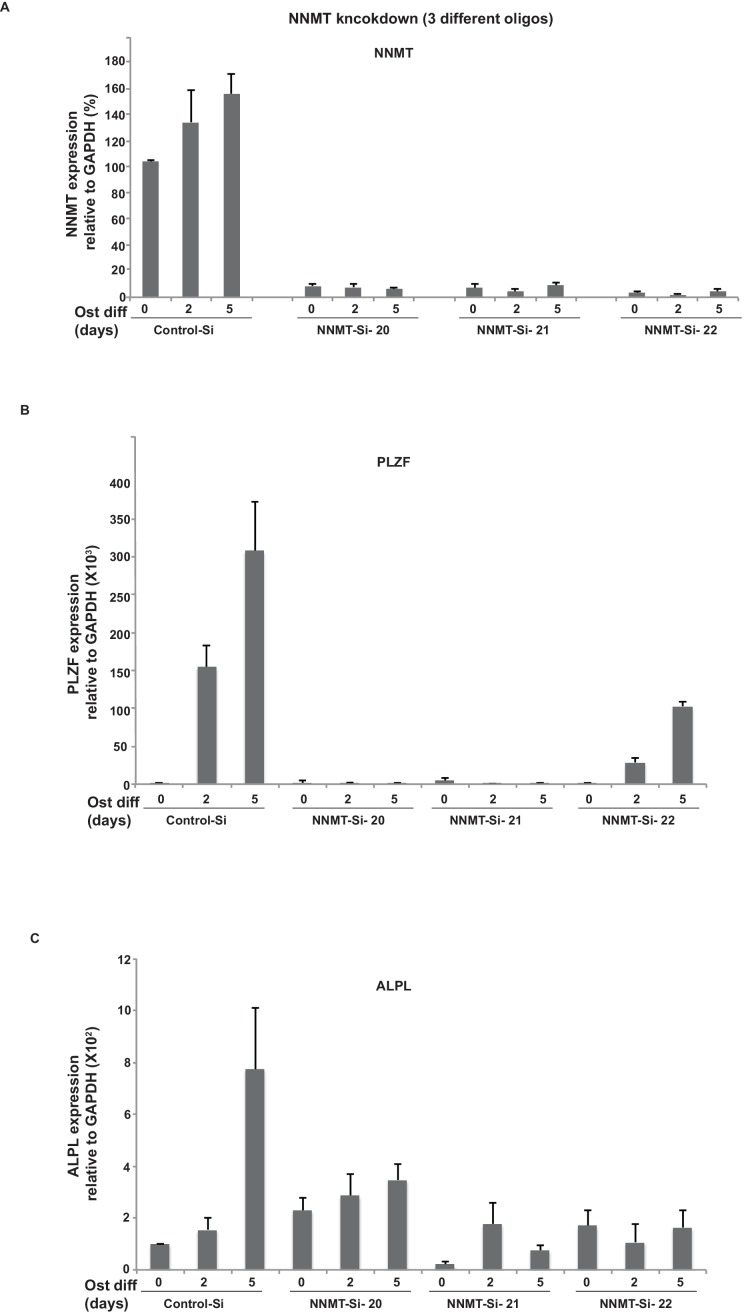
(A) NNMT knockdown using three different siRNA oligos (20, 21, 22) in naïve and osteogenic differentiated (2 and 5 days) hMSCs, assessed by Q-RTPCR.Experiments shown are mean ± SD from triplicates of Q-PCR experiment. The siRNA oligos were ordered from sigma mission and oligo IDs are given in supplementary file 9. (B) Expression of PLZF/ZBTB16 and C) ALPL, after NNMT knockdown (three siRNA's) analyzed by Q-RTPCR. Experiments shown are mean ± SD from triplicates of Q-PCR experiments.